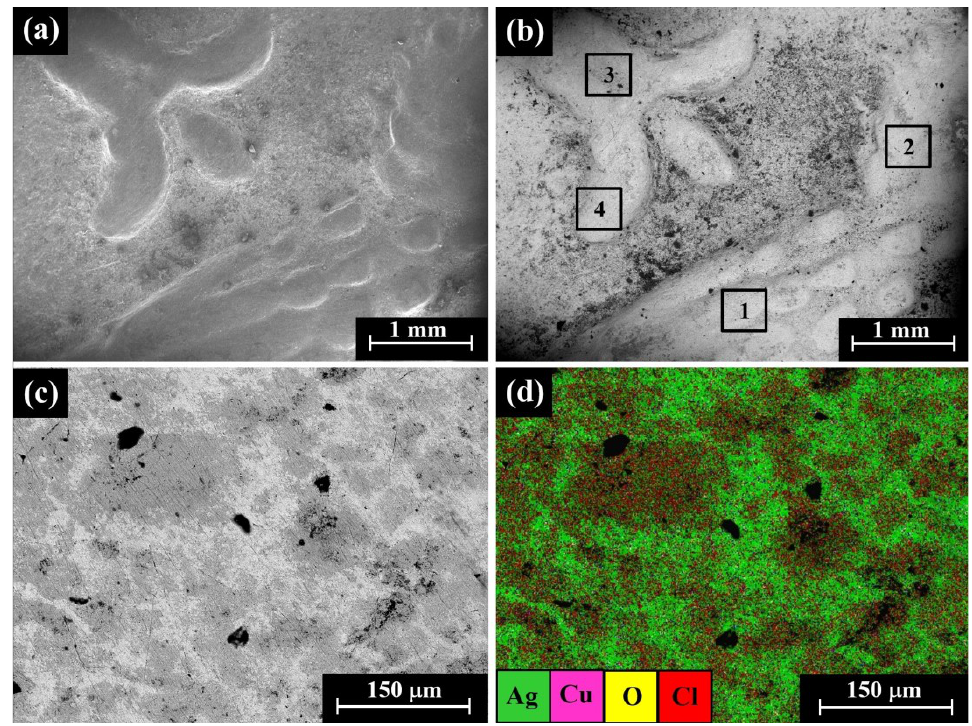
Figure 7. SEM images of the Yehud gerah Type 5 O1/R3 coin IAA 153978: ( a ) reverse, images of a lily and an owl, SE mode; ( b ) reverse, BSE mode, where the bright areas 1 – 4 inside the squares were examined by EDS analysis; ( c ) obverse, BSE mode; and ( d ) elemental mapping, where the green areas are rich in silver and red areas are rich in chlorine.